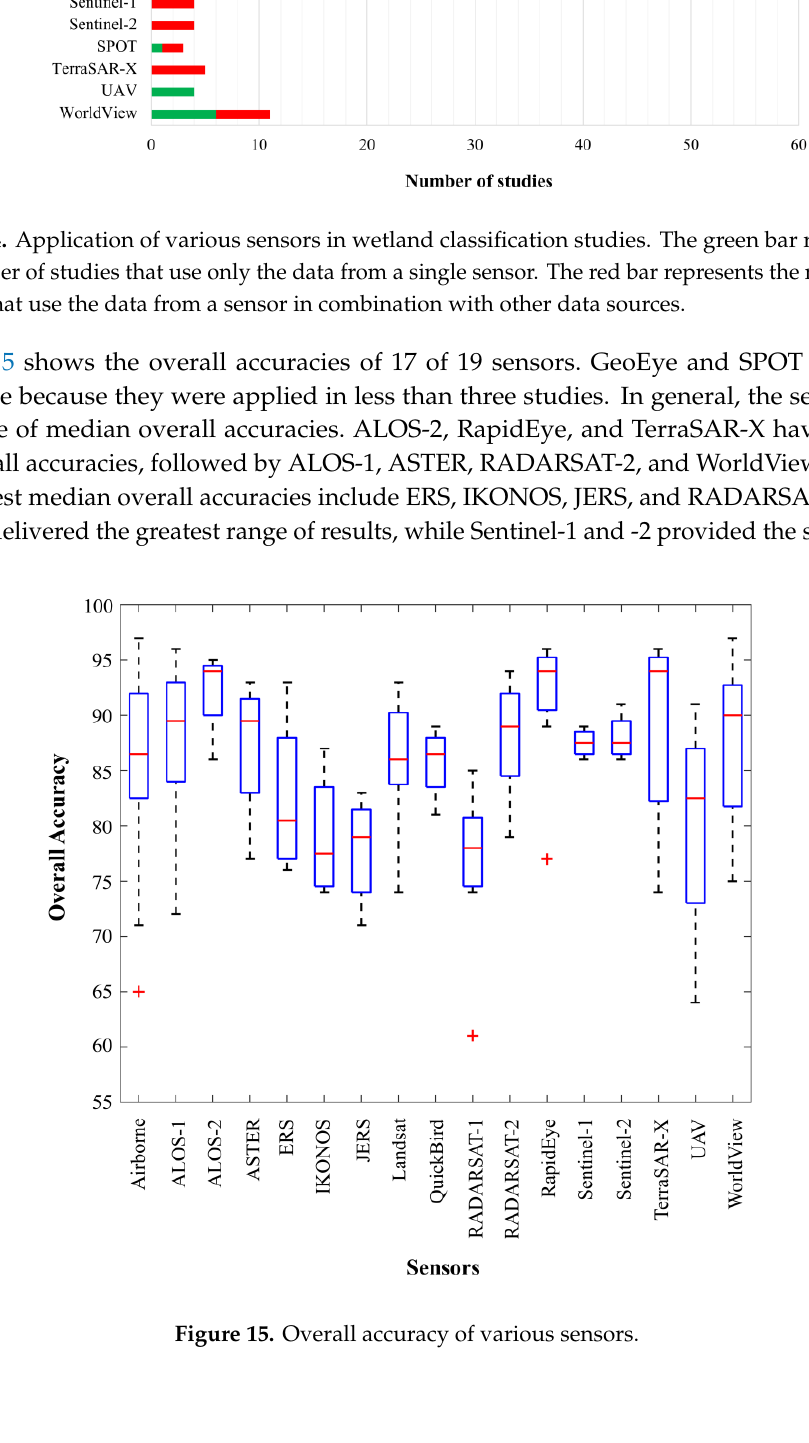
Figure 16. Correlation of overall accuracy and spatial resolution. 476 477